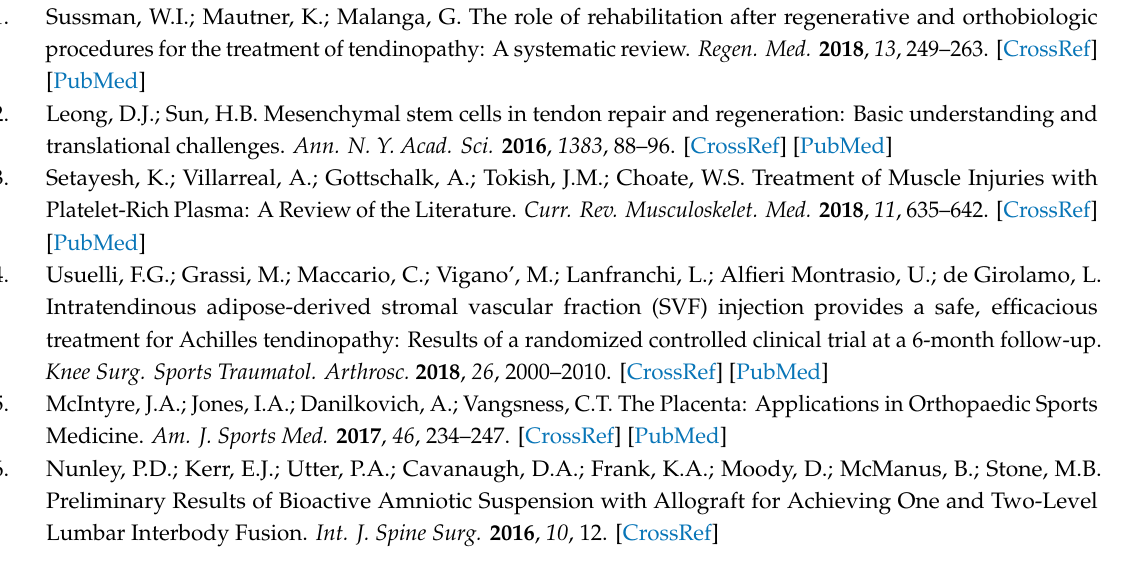
Table S1: Raw scores for histological evaluation of tendons on H&E stained sections. Author Contributions: L.d.G. and A.H.G. conceived the study and L.d.G., J.P.M., K.C.M., and A.H.G. designed the study. L.F.M.A., A.T.P., and K.A.J. completed the animal procedures, L.F.M.A. completed the mechanical testing, L.d.G. and C.P.O. completed the histological staining and grading, and C.P.O. completed the immunohistochemistry. L.d.G., J.P.M., K.A.K., K.C.M., J.L.W. and A.H.G. analyzed and interpreted the data, and K.A.K., L.d.G., and C.P.O. were major contributors to the manuscript. All authors read and approved the final manuscript. Funding: This study was funded by